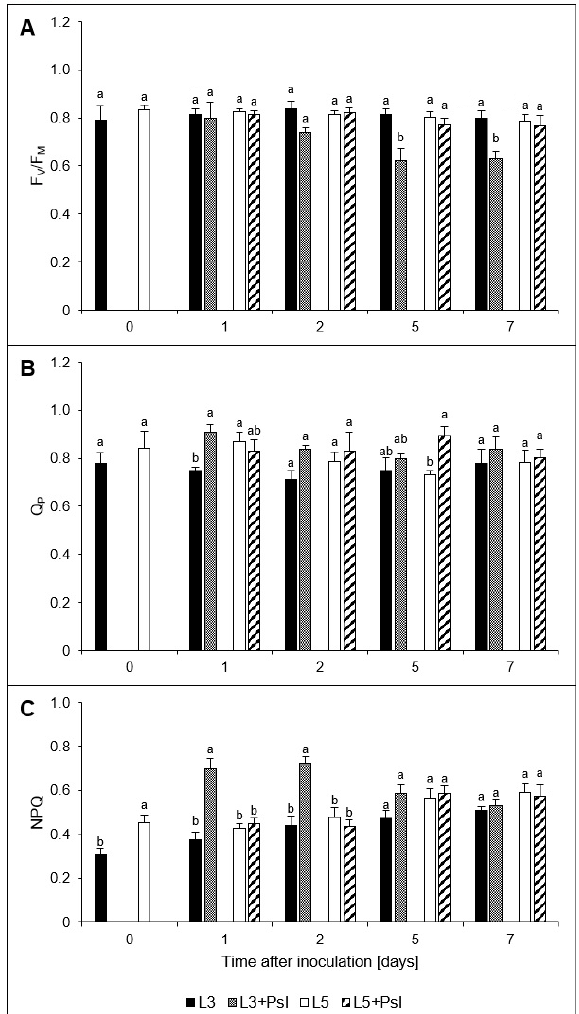
Figure 2. Chlorophyll fluorescence parameters: ( A ) the maximal yield of PSII ( F v / F m ), ( B ) the coefficient of photochemical quenching ( Q P ), ( C ) non-photochemical quenching (NPQ). Values are means of four replicates (±SD). Different letters (a – b) indicate significant ( p ≤ 0.05) differences between experimental variants within a given time point.